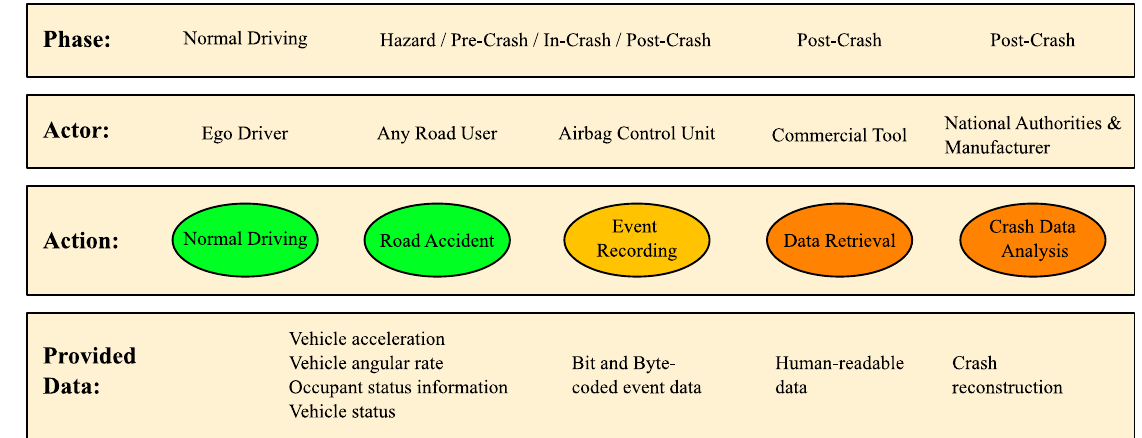
Figure 2. Phases of an accident and the provided data.